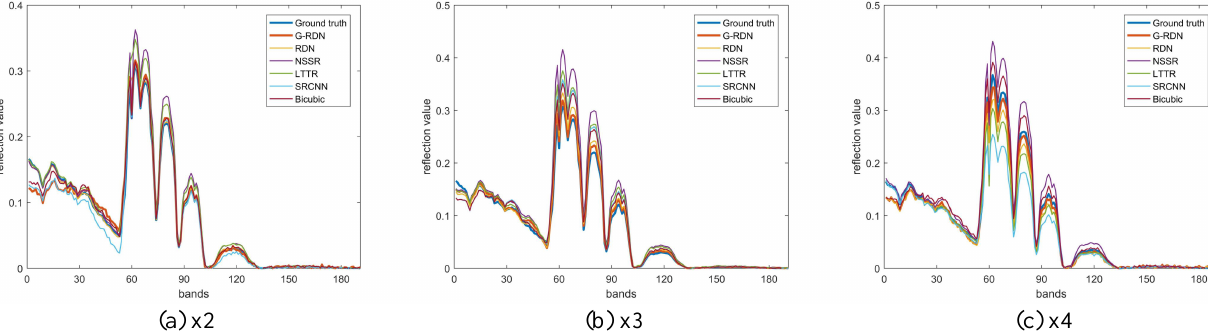
Figure 16. Visual exhibition of the spectral curves of a randomly selected pixel in the reconstructed Washington DC